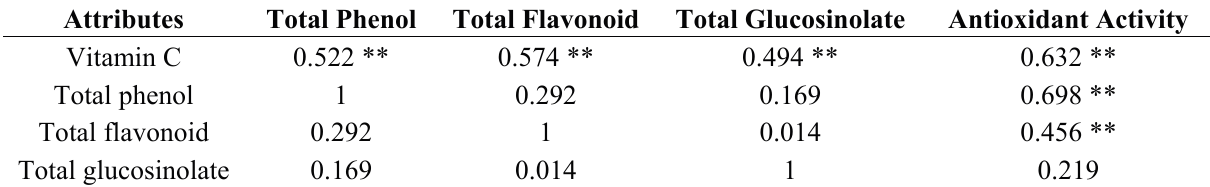
Table 4. Correlation coefficients among phytochemicals and antioxidant